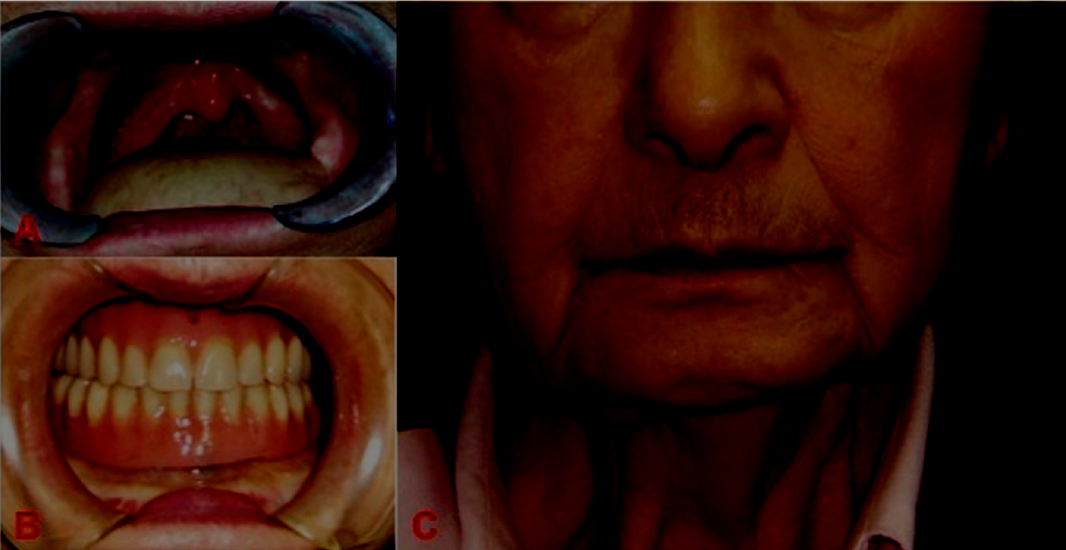
Figure 4. Case 2: ( A ) Post-operative intraoral view; ( B ) post-operative intraoral view (FFD, 5 years after surgery and adjuvant chemo-radiation therapy) with dental prosthesis retained using four titanium implants; ( C ) post-operative frontal view of the patient showing no scars on the chin and lip.